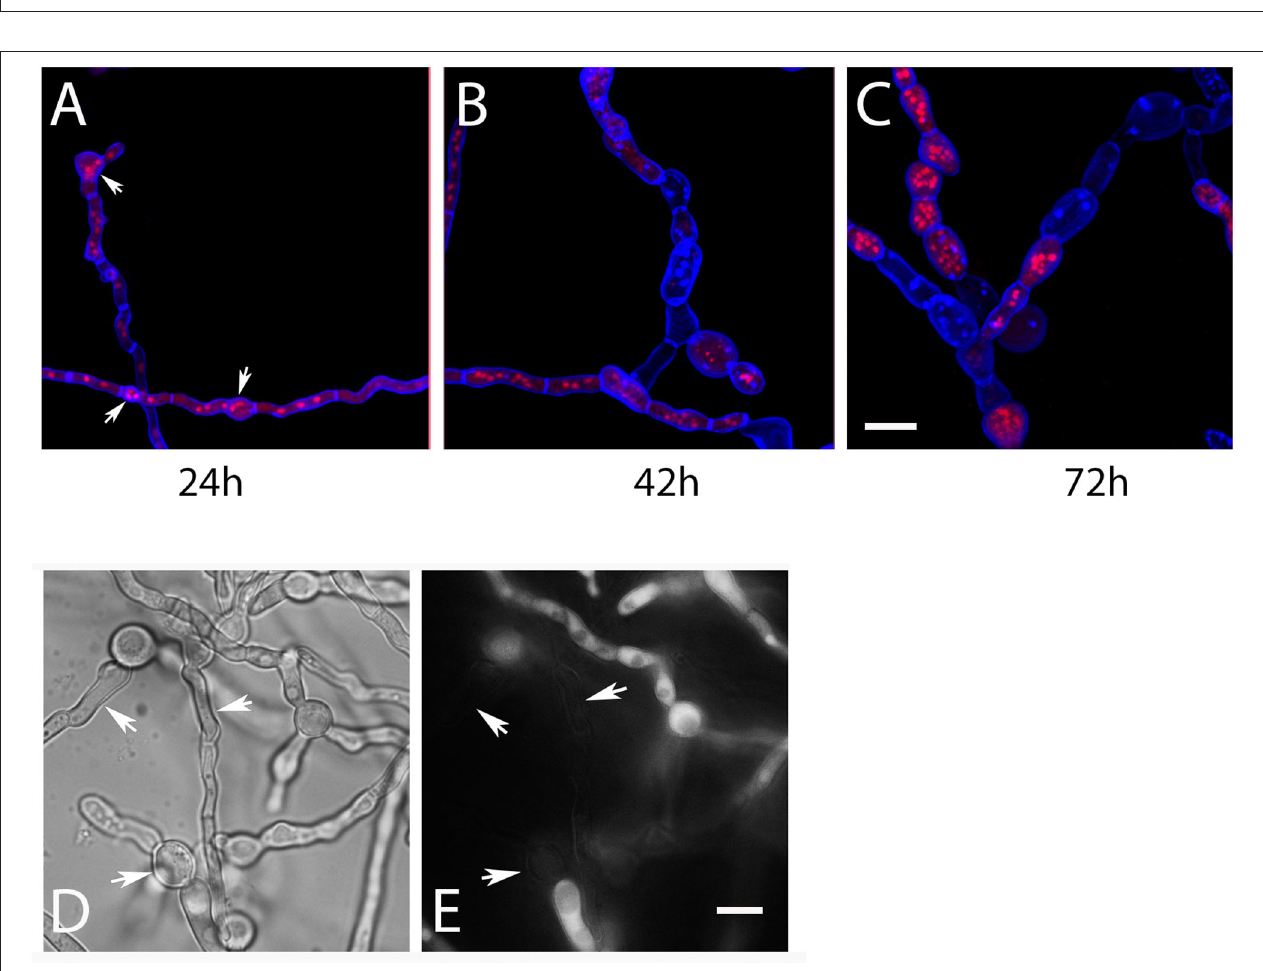
FIGURE 2 | conditions, the growth of the mutants is strongly impaired (B) . Microscopic images of hyphae from the edges of these colonies are shown in (C – I) . The hyphae of the parental strain show a normal morphology and a normal CFW staining (C,D) . The mutant hyphae are short, swollen and contain many septa (E,G) . A stronger chitin staining of mutant hyphae with CFW is evident from (F) and (I) (compared to the control staining in D ). The swollen compartments of mutant hyphae harbor elevated numbers of nuclei [arrows in (H,I) ]. Some of these compartments were already lysed and lacked nuclei [arrowhead in (H,I) ]. The bars shown in (C , F) represent 30 and 10 µ m, respectively, and are valid for (C–F) and (G–I) . The images shown in (D,F,H,I) are maximum projects of z-stacks.